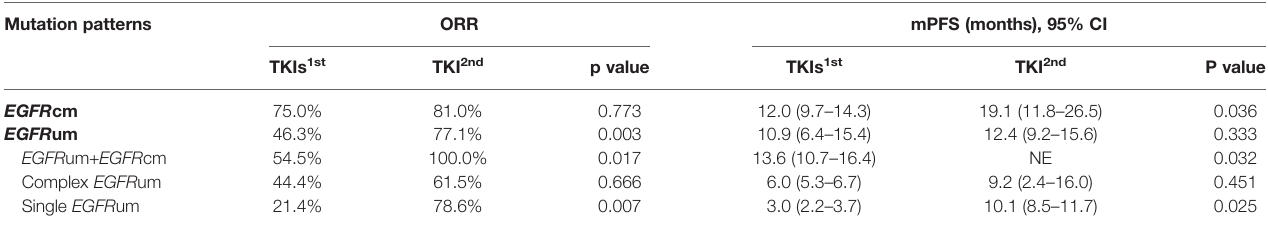
EGFR, epidermal growth factor receptor; TKI, tyrosine kinase inhibitor; ORR, objective response rate; PFS, progression-free survival; NE, not evaluable; EGFRcm, common EGFR mutations; EGFRum, uncommon EGFR